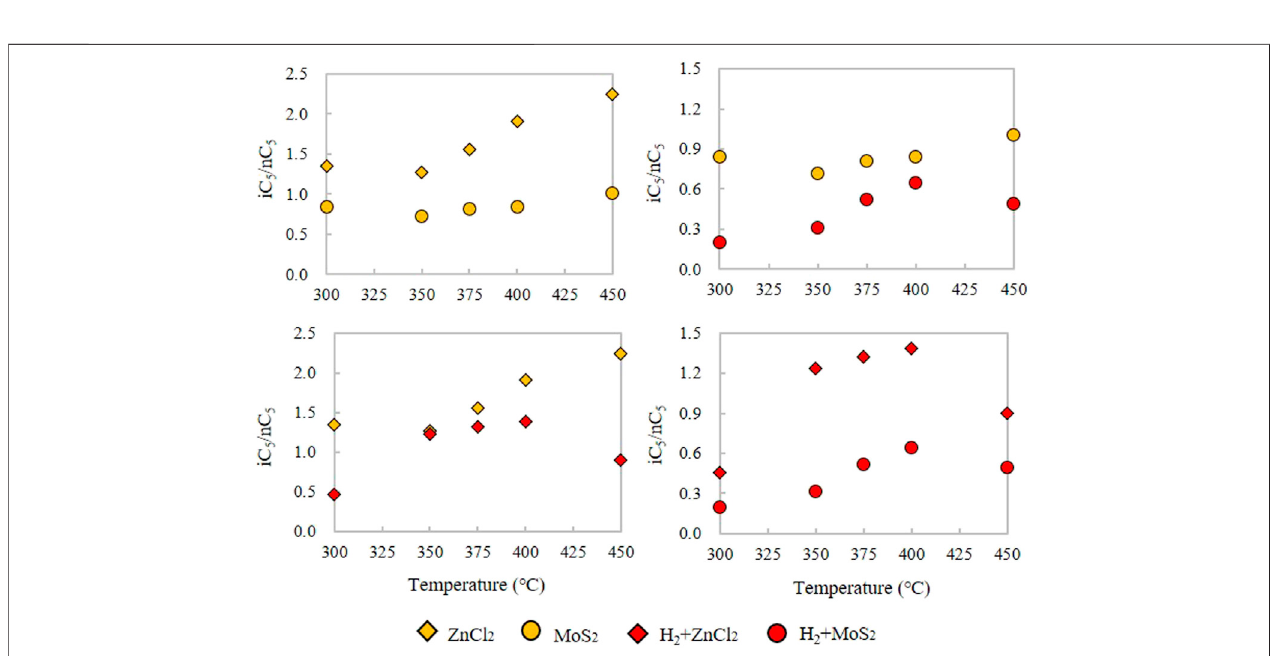
FIGURE 9 | Comparison of the iC 5 /nC 5 alkane ratio under the ZnCl 2 , MoS 2 , H 2 +ZnCl 2 , and H 2 +MoS 2 conditions for the kerogen in closed system.